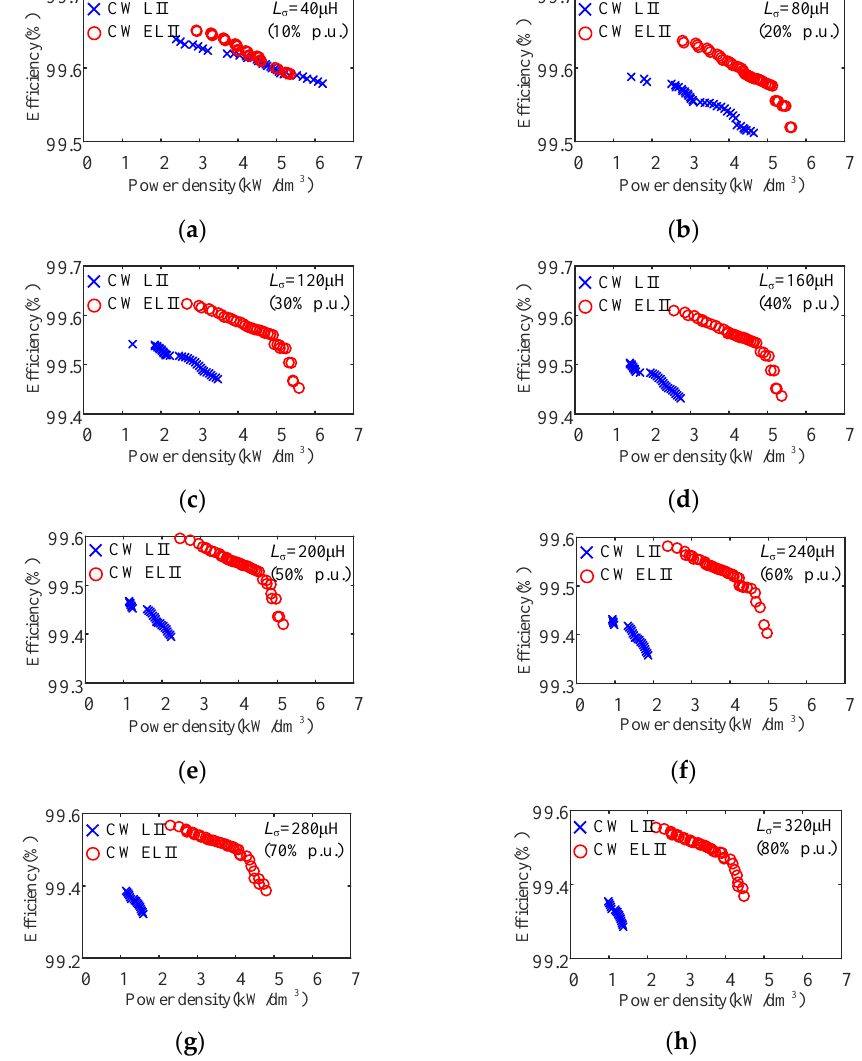
Figure 21. Pareto fronts of CW LII and CW ELII solutions with different leakage inductances. ( a – h ) leakage inductance: 10% p.u. to 80% p.u. (40 μH to 320 μH).